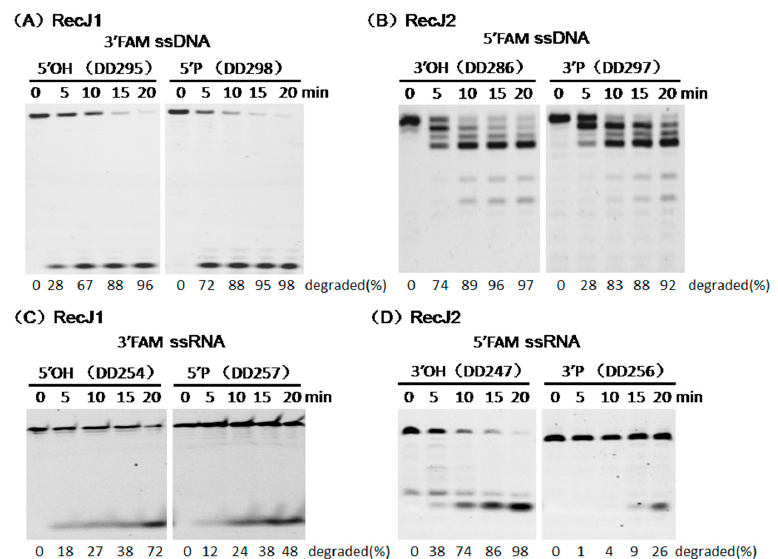
Figure 5. Effect of terminal phosphate group on M. jannaschii RecJ activity. Two MjaRecJs (40 nM RecJ1 or 50 nM RecJ2) were incubated with 200 nM 23 nt ssDNA or 12/16 nt ssRNA substrates in their respective reaction buffer at 55 ◦ C with increasing time. The substrates are labeled with fluorescence group FAM at 5 (cid:48) or 3 (cid:48) end, and have 3 (cid:48) or 5 (cid:48) terminal phosphate groups. The degraded amount of